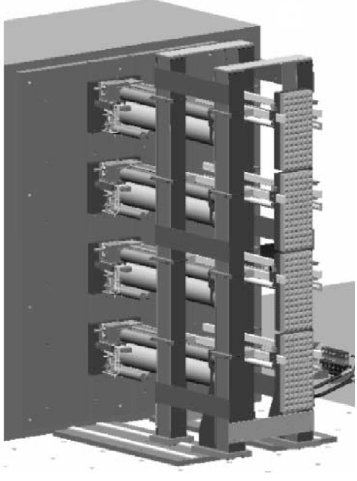
Fig. 2. Array of blast generators with impacting modules attached [20].